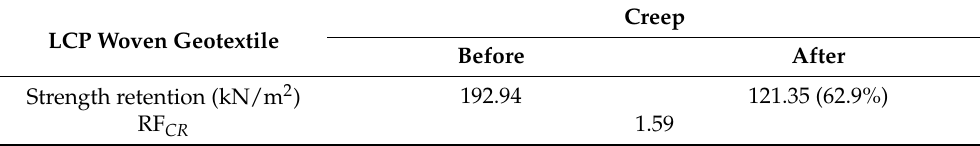
Table 4. Strength retention and reduction factor for creep deformation of LCP woven geotextile. LCP Woven